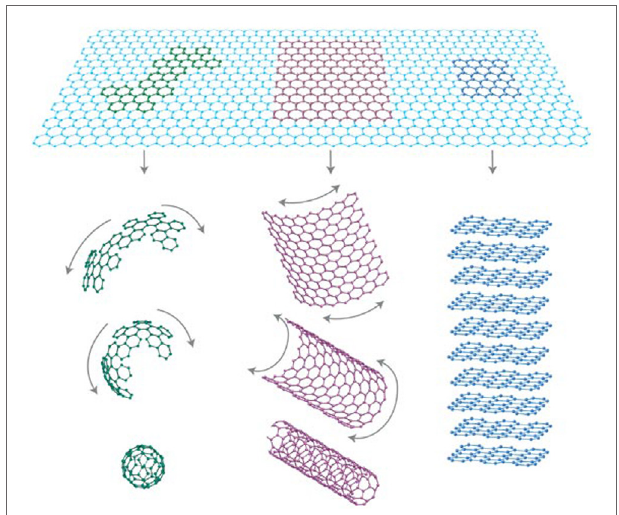
FiGURe 2 | Graphene is the basic building block of other carbon structures, including 0D fullerene, 1D CNT, and 3D graphite . (Geim